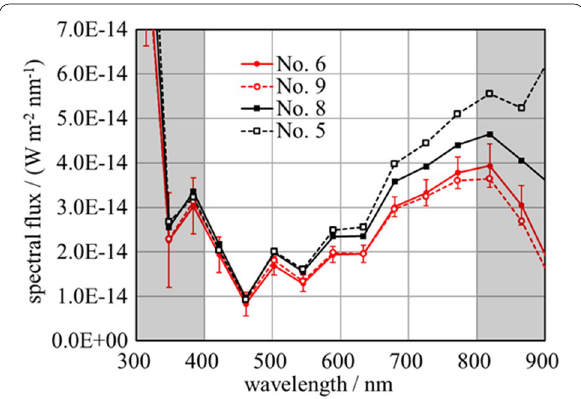
Fig. 16 The effect of the incomplete spectral flat-filed correction on a spectrum. We derived the spectra at the 2nd-frame of Flash 170201 with the four different reference points in a video frame for the spectral flat-field correction. The reference points are No. 6, 9, 8, and 5 in Fig. 14 in the increasing order of distance from the flash in a frame. The reference point for a comparison star was fixed to No. 5